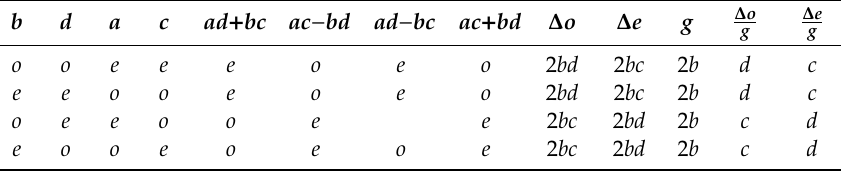
Table 2. Parity considerations for